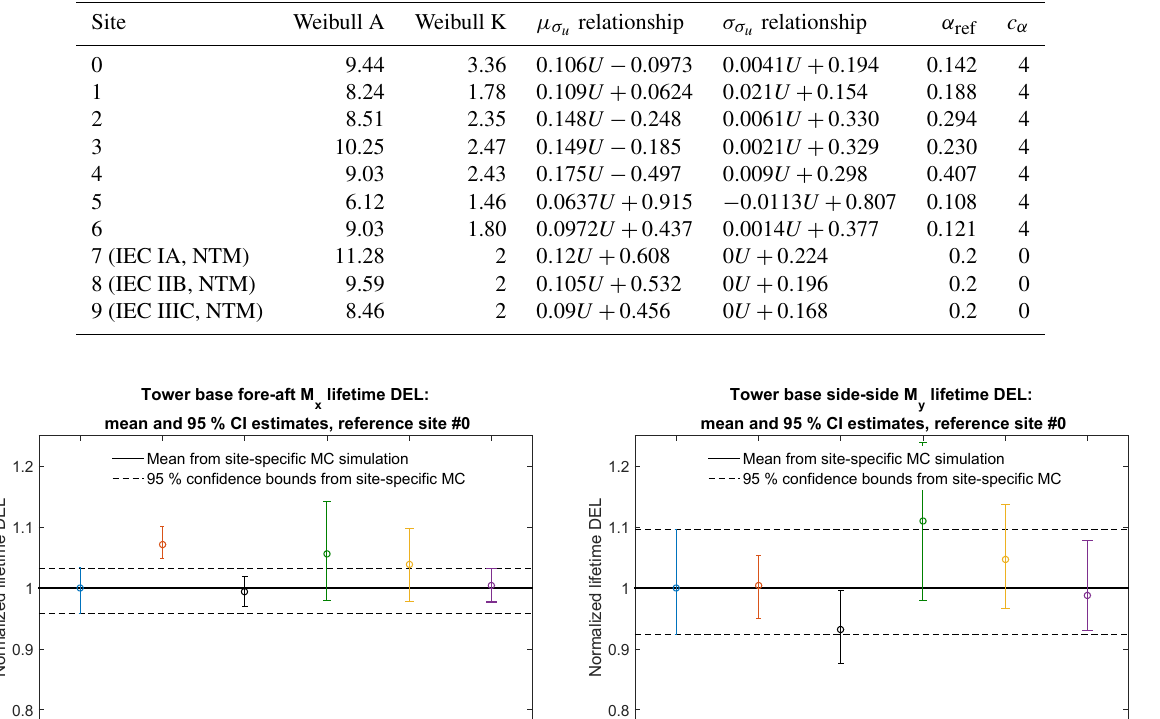
Table 6. Parameters defining the conditional distribution relationships used in computing joint distributions of the environmental conditions for the test sites/conditions.